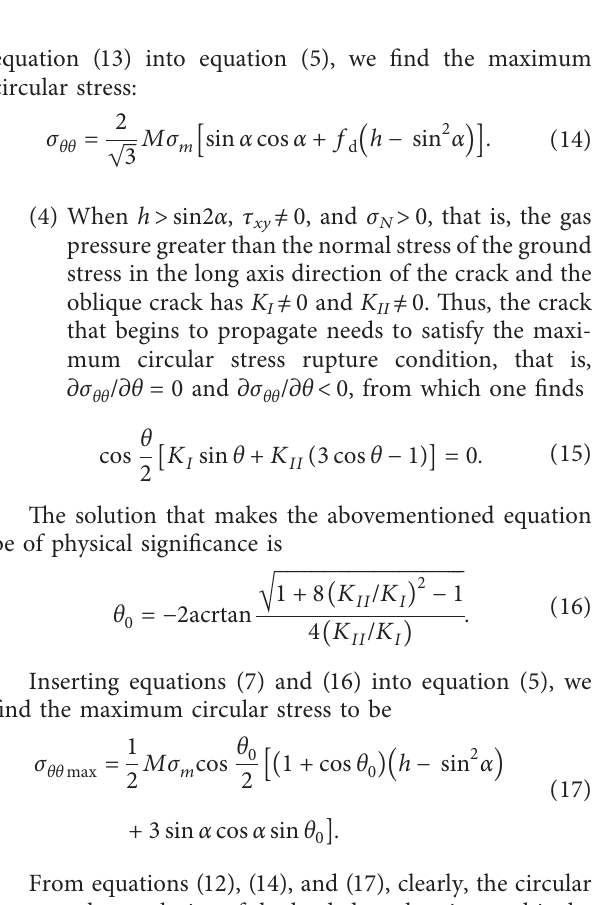
Figure 4: Relationship between circular stress at the crack tip and crack angle.